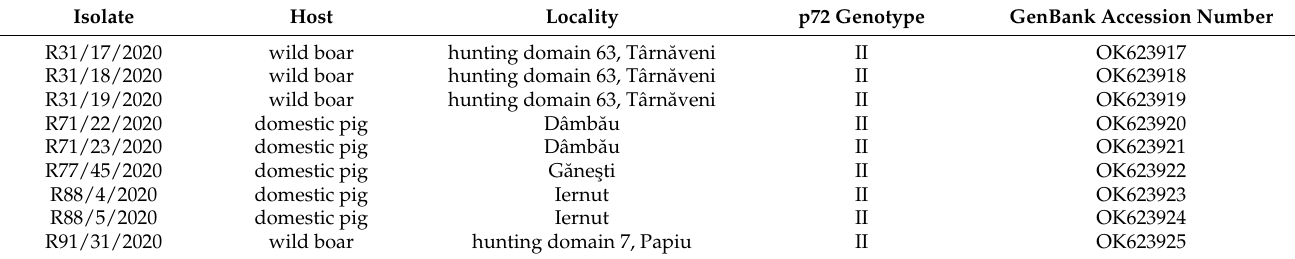
Table 1. African swine fever virus isolates selected for genotyping from wild boars and domestic pigs after virus isolation, Mures County, Romania, 2020. ,